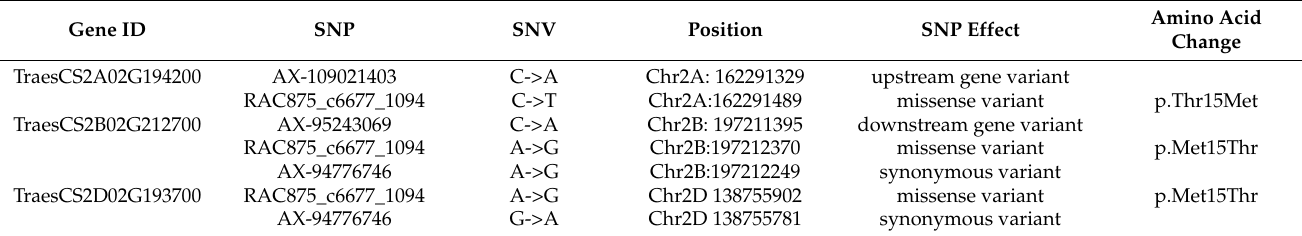
Table 2. Description of SNPs within TaRSL4